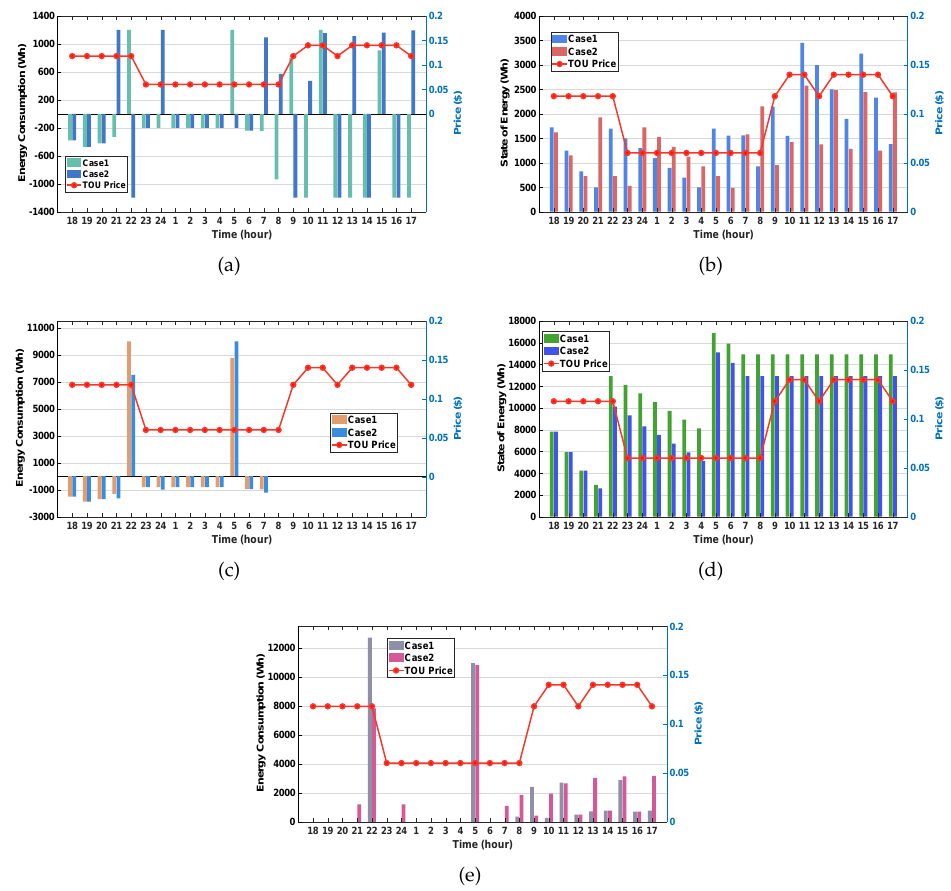
Figure 5. Performance comparison between Case 1 and Case 2. ( a ) energy consumption of the energy storage system (ESS); ( b ) state of energy (SOE) of the ESS; ( c ) energy consumption of the electric vehicle (EV); ( d ) SOE of the EV; ( e ) net consumption of